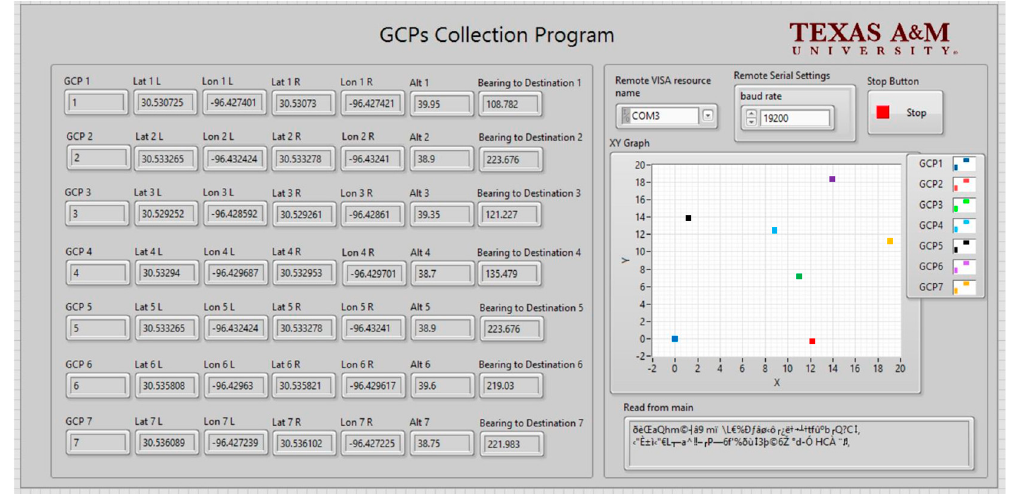
Figure 10. User interface of the GCPs collection program.